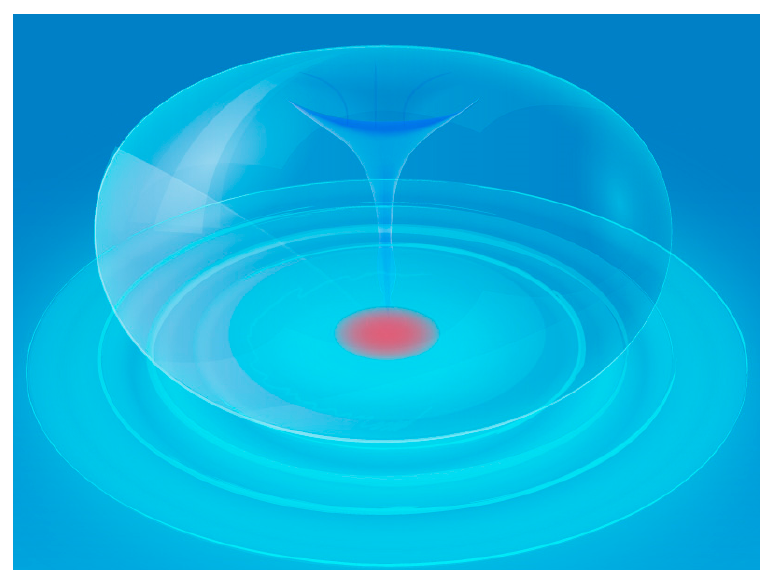
Figure 3. A cavitation bubble imploding onto a surface [16].